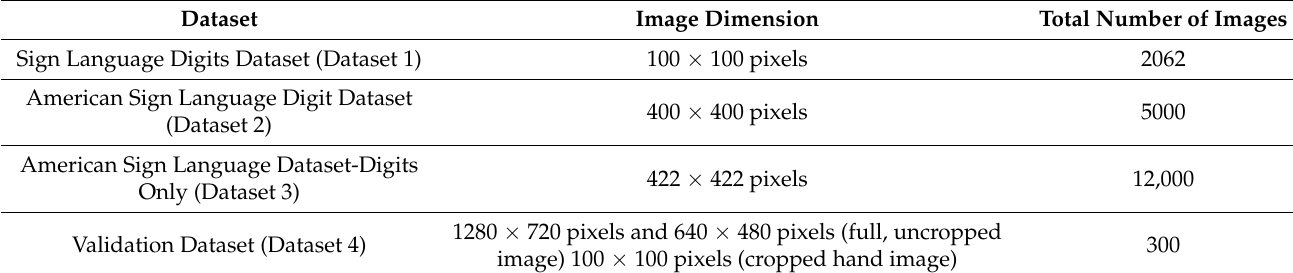
Table 1. List of